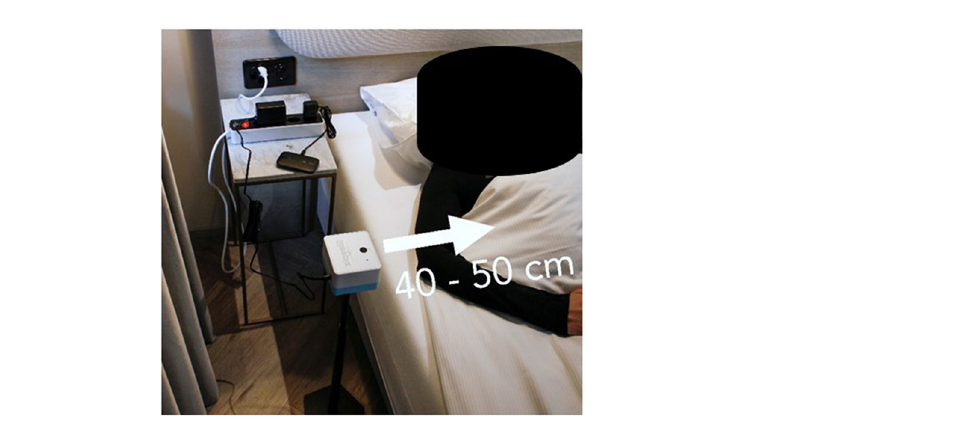
Figure 2. Placement of Sleepiz One+